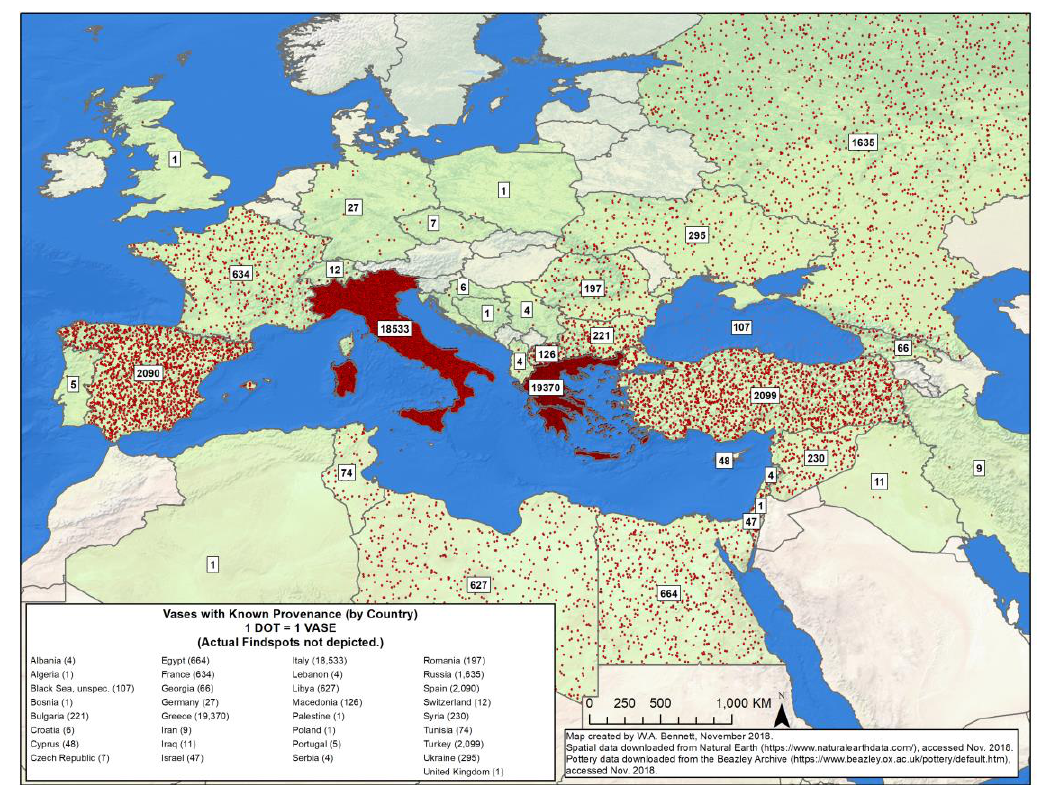
Figure 3. Map showing the general distribution of vases with known provenance using the data from the BAPD. Please note that this map is a dot-density map within modern country borders and does not represent the actual findspots of each vase. Vases with no known provenance are not represented. Credit: Produced by Wesley A. Bennett for the author’s